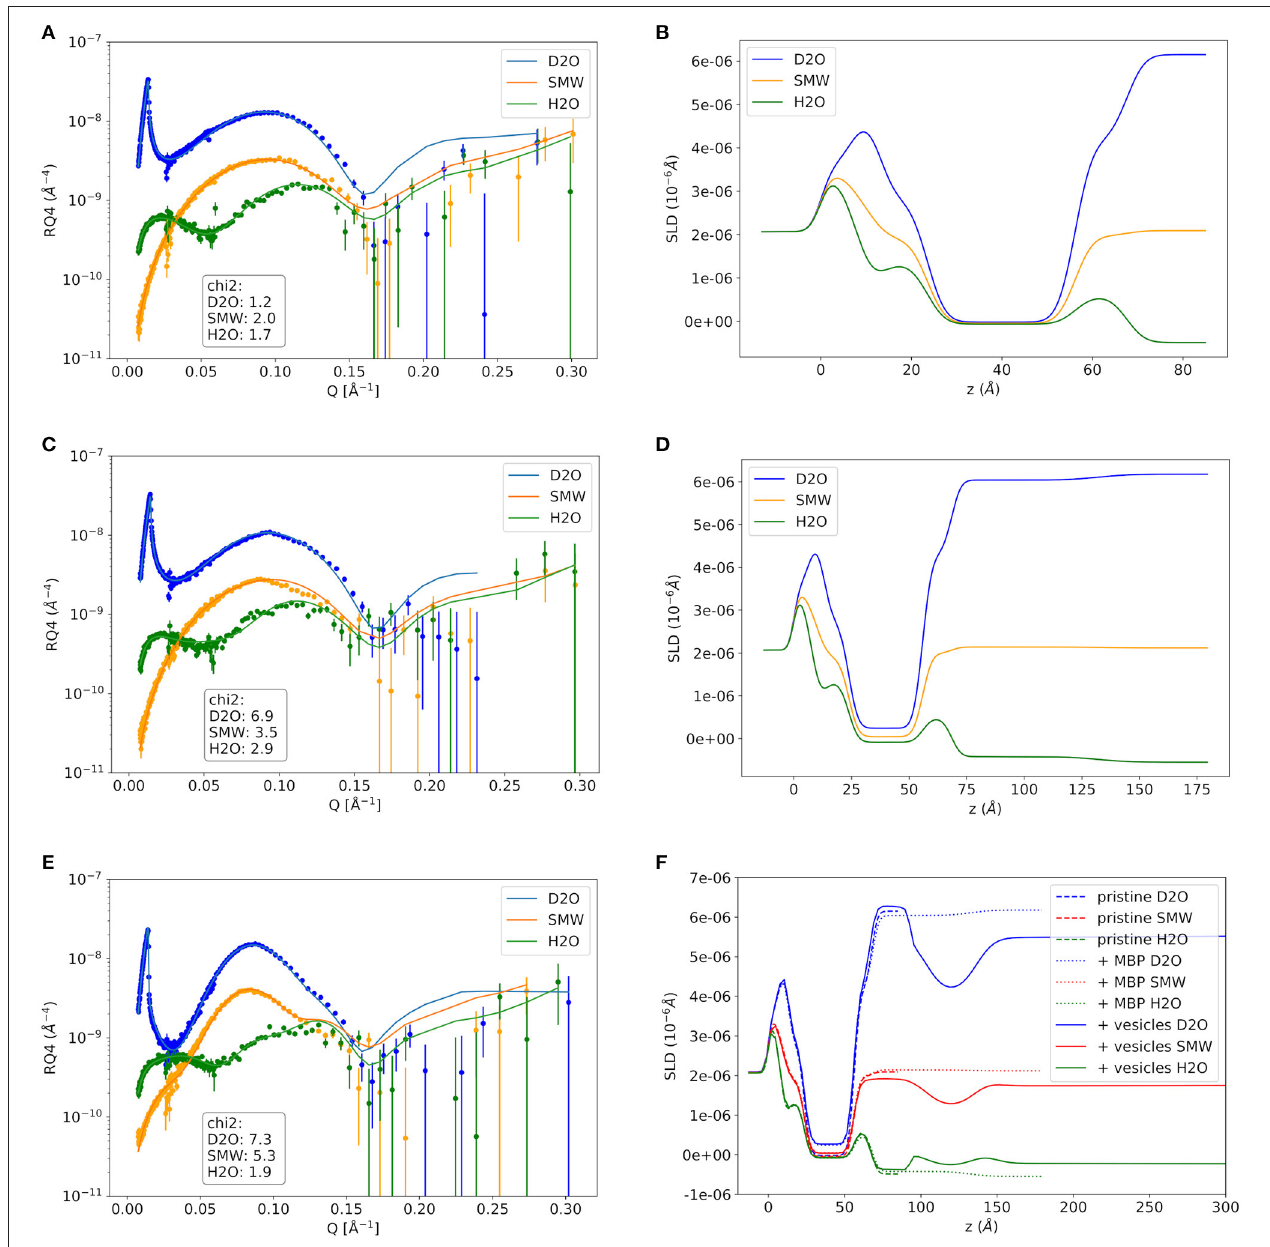
FIGURE 4 | Neutron reflectivity curves and respective SLD profiles of the EAE Modified01 sample. (A,B) The pure EAE membrane without MBP, (C,D) the supported EAE membrane with MBP protein layer on top that was formed by addition of protein solution with 0.1 mg/ml MBP, and the double-EAE-membrane structure with dense intramembrane MBP-layer that was formed after vesicle adhesion in (E,F) . In (F) the SLD profiles of the pristine membrane and the MBP coated membrane are shown as comparison. NR data was measured on the D17 neutron reflectometer.